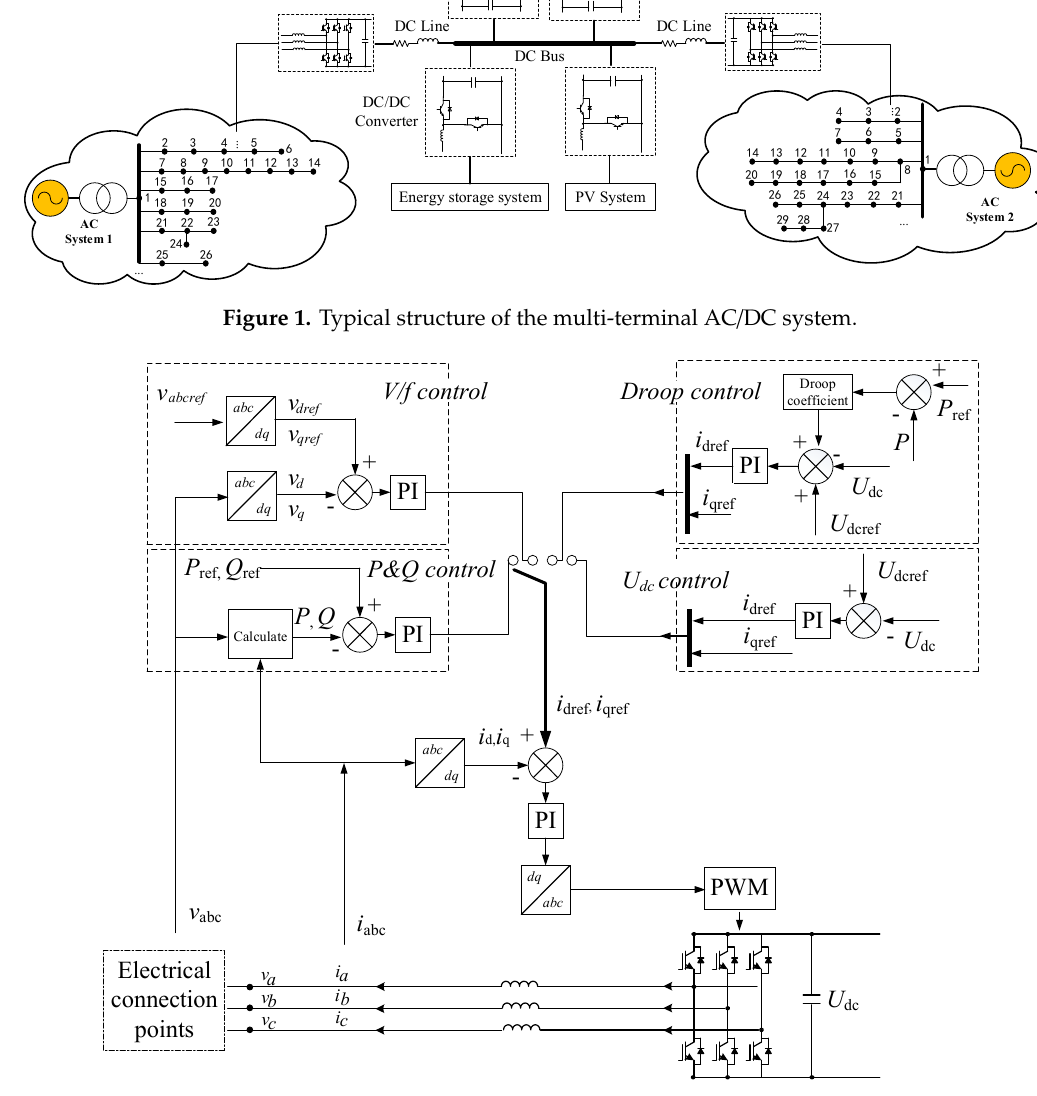
Figure 2. Classic VSC control strategies.